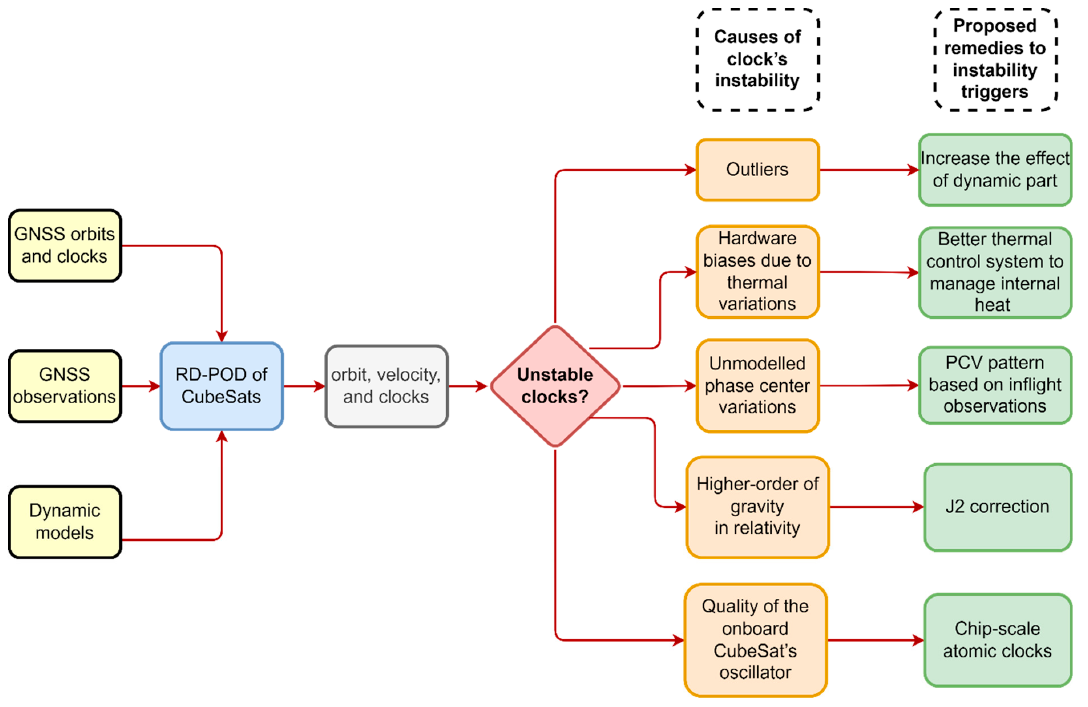
Figure 3. Flowchart indicating CubeSats’ clock instability assessment and the proposed remedies.